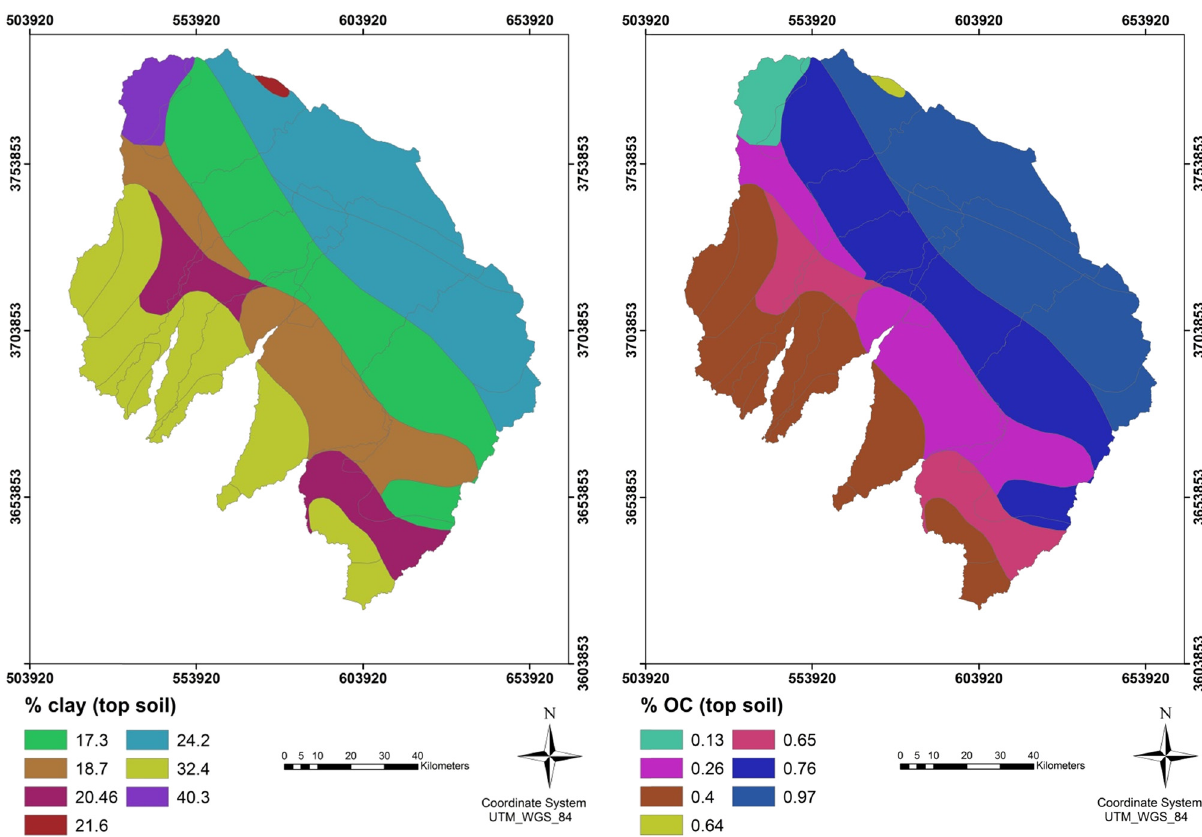
Figure 9: Clay percentage distribution of study area topsoil.